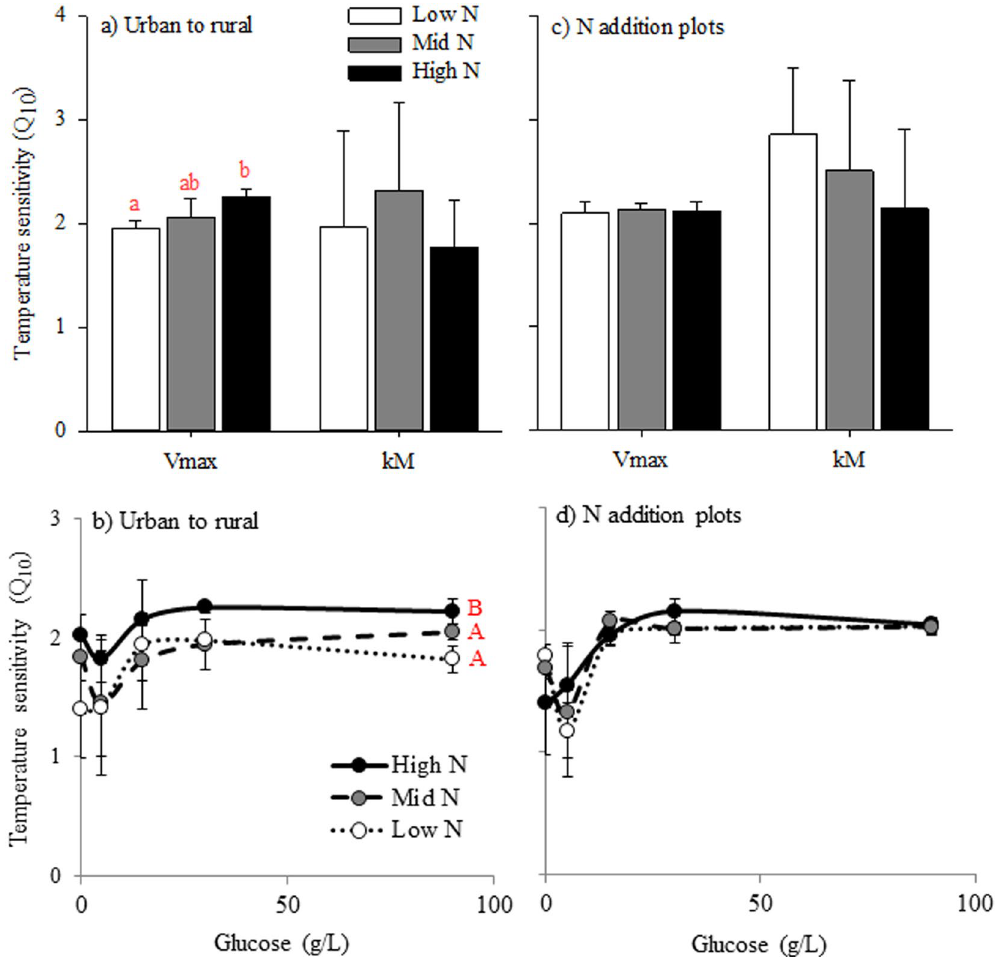
Figure 4. Temperature sensitivity (Q 10 ) of the Michaelis-Menten parameters V max and kM ( a , c ), and Q10 versus glucose addition ( b , d ). Error bars represent standard deviation. Letters represent significant difference at p < 0.05 from one-way ( a , c ) or 2-way ( b , d ) ANOVA followed by Tukey HSD (n = 5 for ( a , b ) and n = 3 for ( b , d